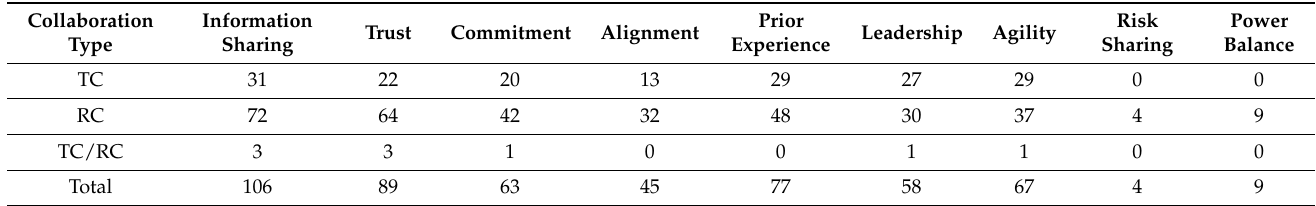
Table 4. The frequency of the main collaborative measures in the literature.